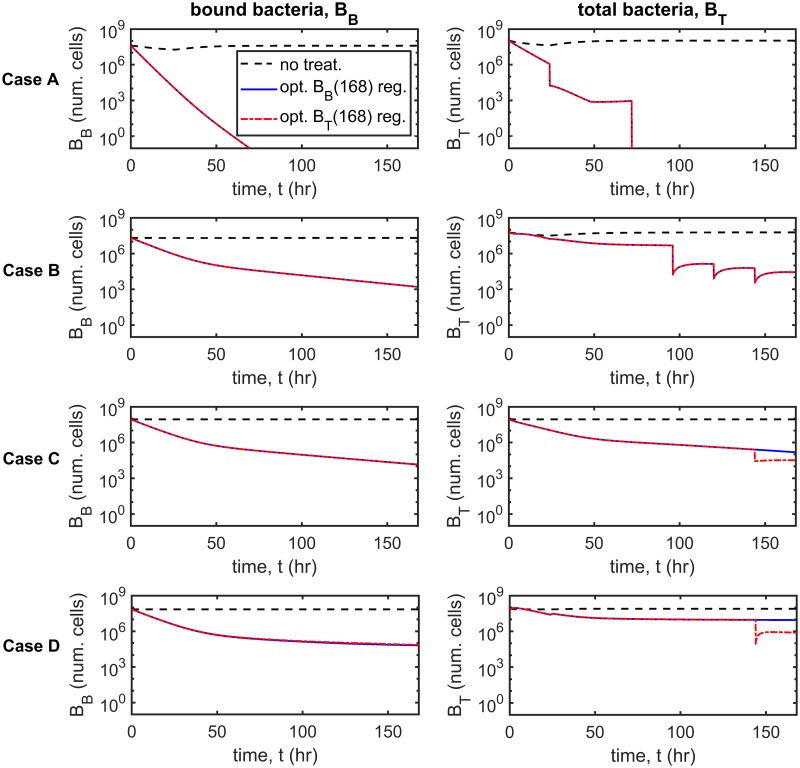
Optimum treatment outcomes—minimising final bacterial burdens with an established infection.Graphs show the dynamics of the bound and total bacterial burdens, BB and BT respectively (columns), in the untreated case and under the optimal treatment regimens (see Fig 13) for each parameter set (rows). Note the log10 scale on the y-axis. The bacterial burden is eliminated (BT(168) < 1) under the optimal treatment regimens in Case A and is significantly reduced in Cases B–D (to O(102) in Case B, O(104)–O(105) in Case C and O(105)–O(106) in Case D, lower values corresponding to the BT(168) optimality condition and higher values to the BB(168) optimality condition where ranges are given). Eqs 1–11 were solved using ode15s, with a constant antibiotic dose. Parameter values: A = 8 μg ml−1, λ = 0 cm3cell−1hr−1, ρ = 0 hr−1 and ω = 1. The initial conditions are the untreated steady-states for each parameter set, modified so that 2% of the free and bound bacteria are resistant. See Tables 2–4 for the remaining parameter values.